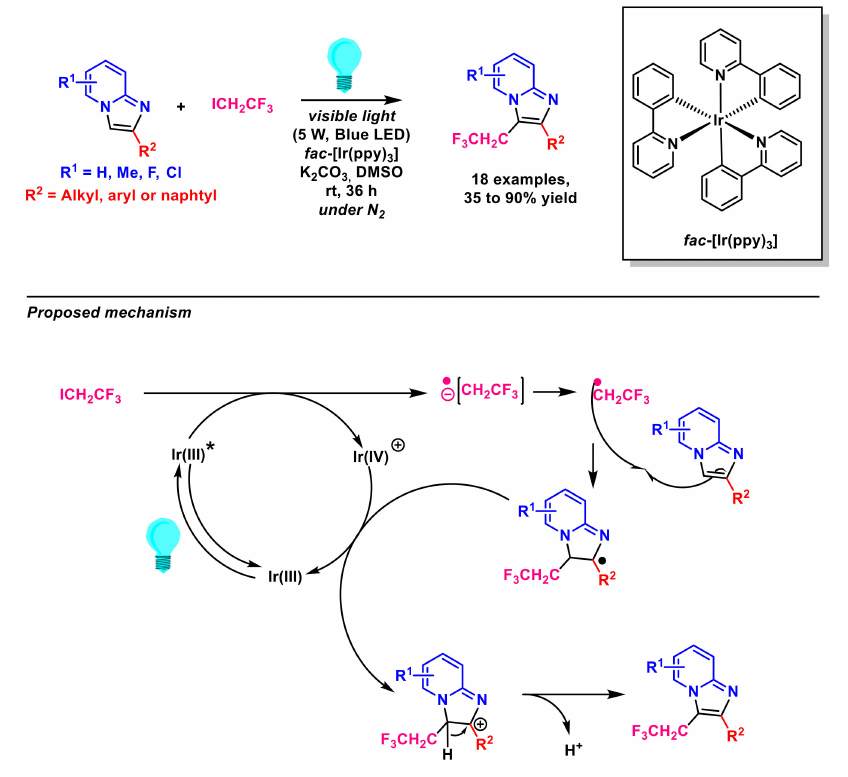
and hydroquinone) jeopardized the reaction since the expected C 3 -perfluoroalkylated imidazo[1,2- a ]pyridine was obtained in low yields. With TEMPO, 2,2,6,6-tetramethyl-1- (perfluorobutoxy)piperidine was identified by GC-MS (gas chromatography–mass spec- trometry) analysis, confirming the radical character of the process.